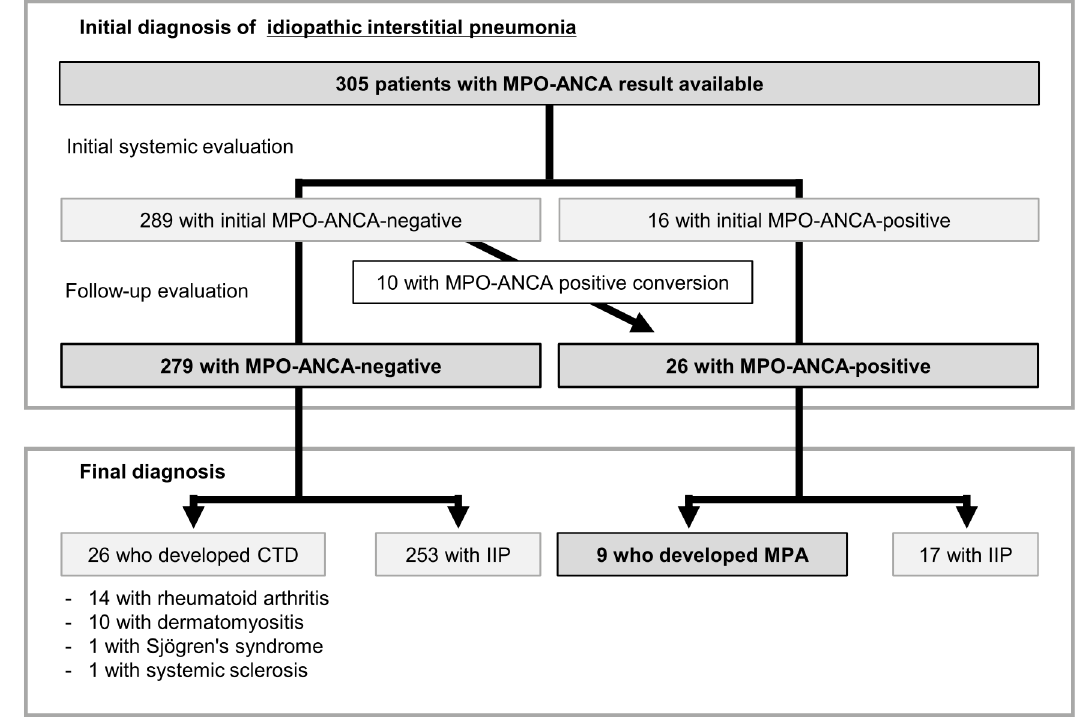
Fig 1. Flow chart of patient classification. CTD, connective tissue disease; IIPs, idiopathic interstitial pneumonias; MPA, microscopic polyangiitis; MPO-ANCA, myeloperoxidase-anti-neutrophil cytoplasmic antibody.